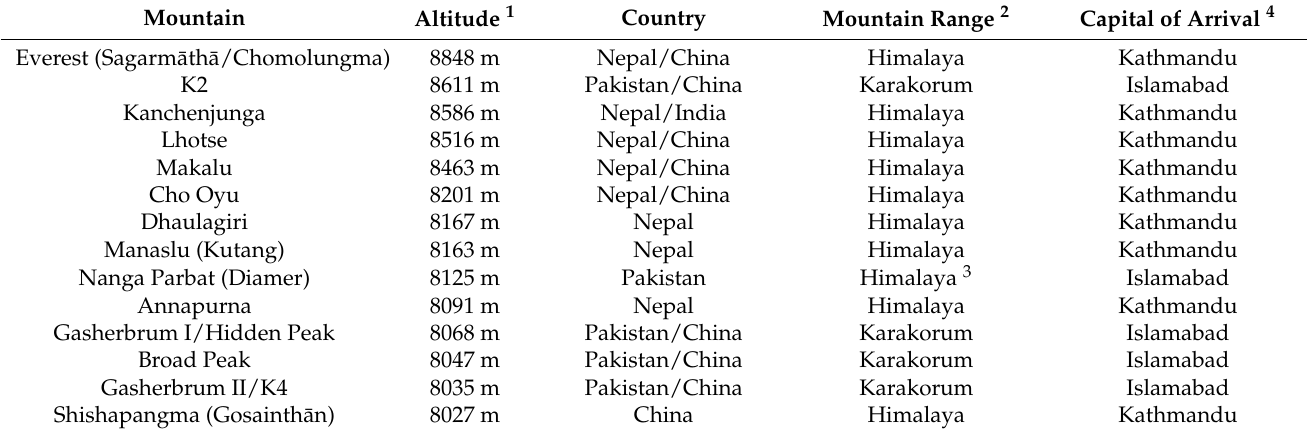
Table 2. The particularities and practical aspects of each 8000 m